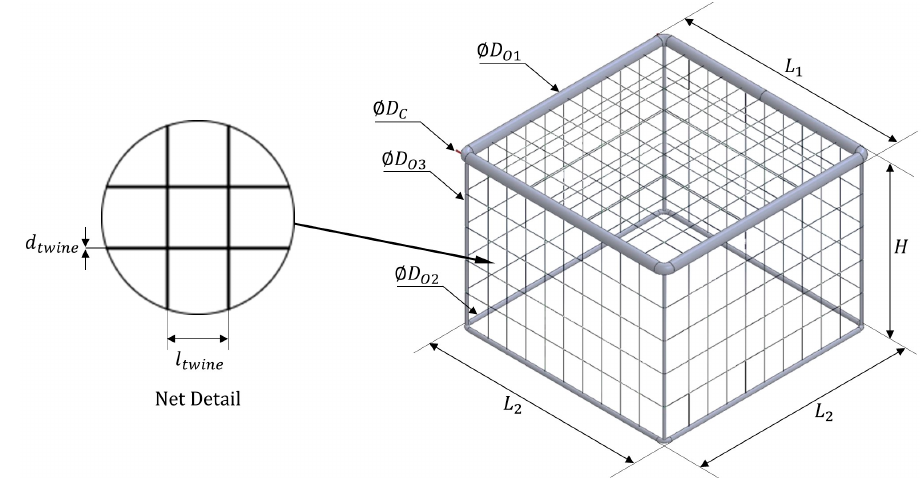
Figure 1. General Arrangement and Component of a single cage, showing the structure parameters.